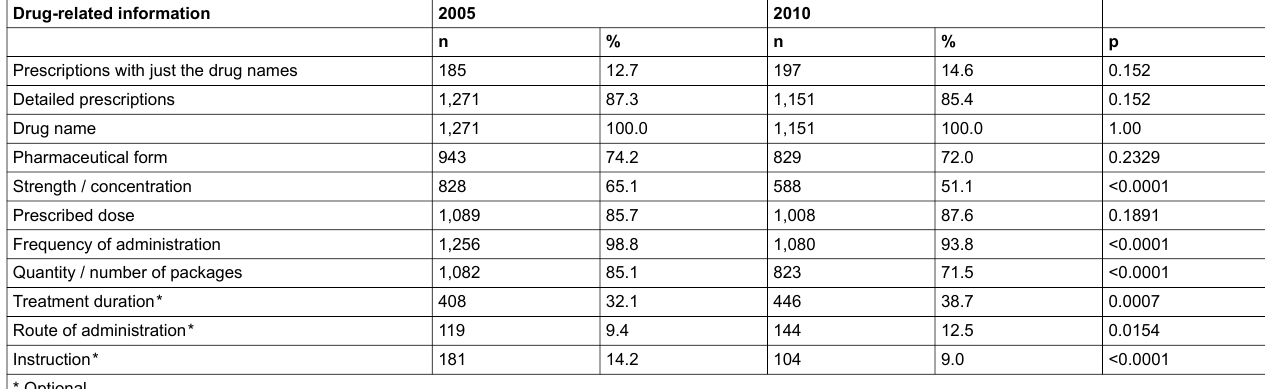
Table 3: Formal criteria regarding the drugs appearing on prescriptions in 2005 (n = 1,456) and 2010 (n =